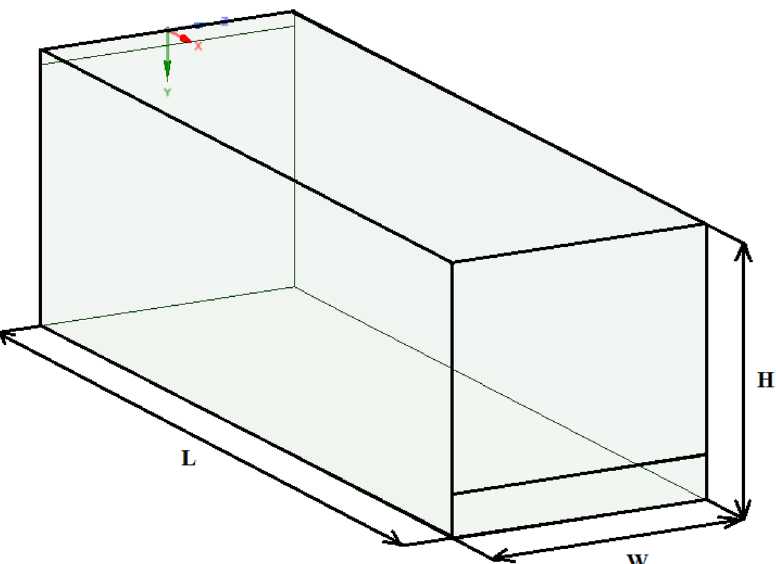
Figure 1. Configuration of the computational domain.